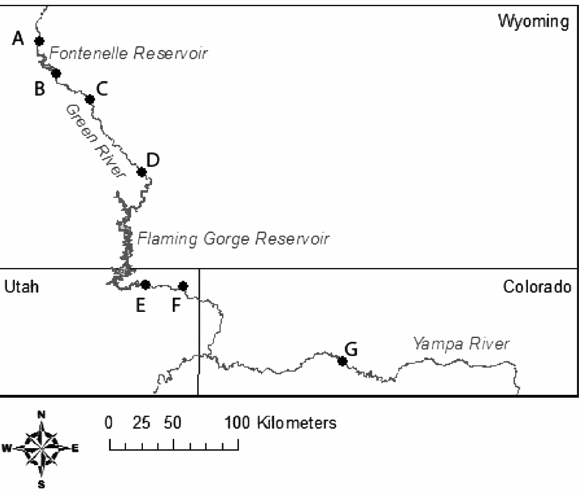
Figure 1. Map of Fontenelle and Flaming Gorge reservoirs located on the Green River in Wyoming and Utah and the Yampa River located in Colorado. The points along the rivers designate the loca- tions from where we collected water from April to October 2011. Two sites located on unregulated river reaches: the Green River above Fontenelle reservoir (A) (USGS gaging station 09209400) and the Yampa River (G) (USGS gaging station 09251000). We also sampled directly below Fontenelle dam (B) (USGS gaging sta- tion 09211200) and 39.6km down river for the Fontenelle tailwater (C). We sampled above Flaming Gorge reservoir (D) (USGS gag- ing station 09217000) and directly below Flaming Gorge dam (E) (USGS gaging station 09234500) and 25.7km further downstream for Flaming Gorge tailwater (F).